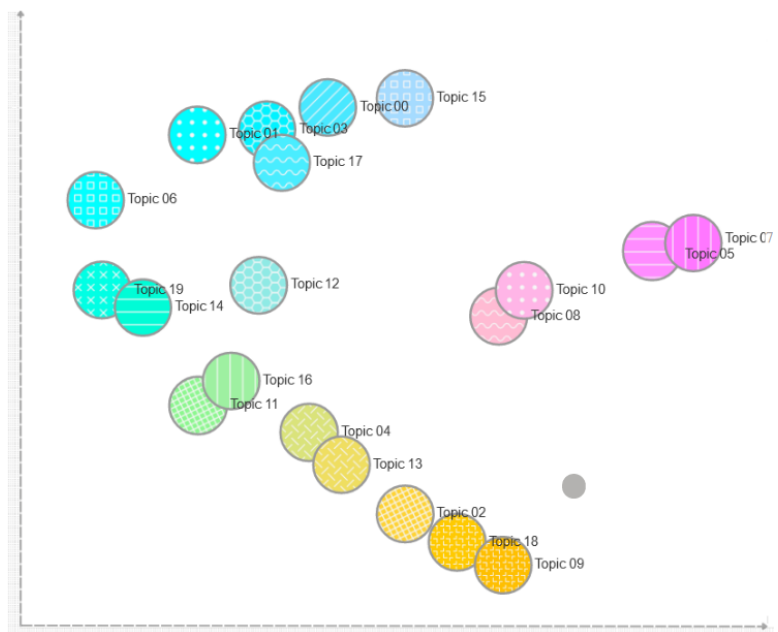
Figure 10. Inter-topic distances in a two-dimensional space by the multidimensional scaling (MDS) method.